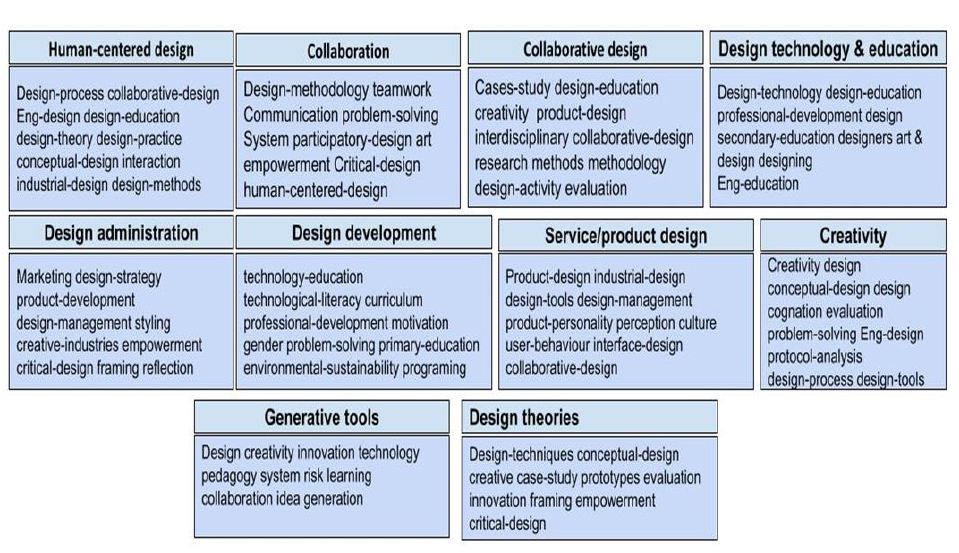
Figure 8. The ten clusters for the time span 2007 – 2011.